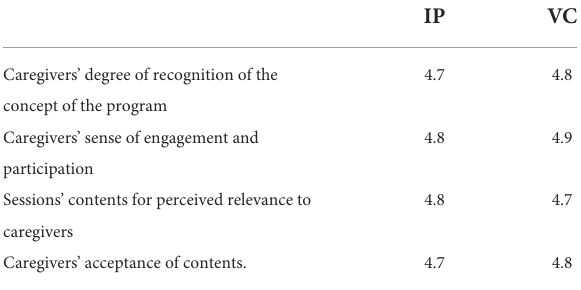
TABLE 4 Facilitator’s Feedback Form (Contents of the